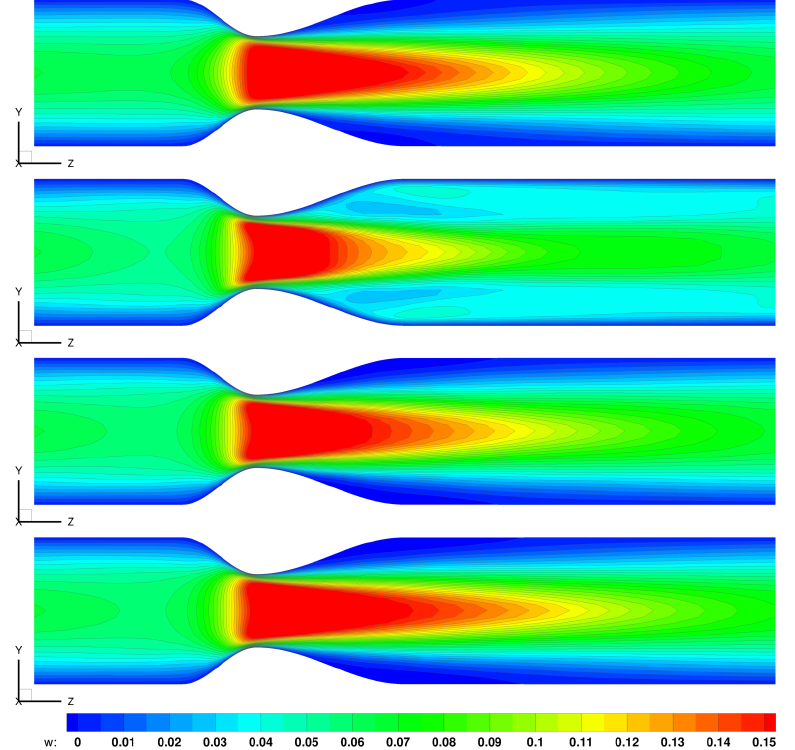
Figure 15. Axial velocity at flow rate Q = 1.0 cm 3 /s—GOB (top figure) and Johnson–Segalman models for a = − 0.9, a = − 0.8, a = − 0.7 (from the